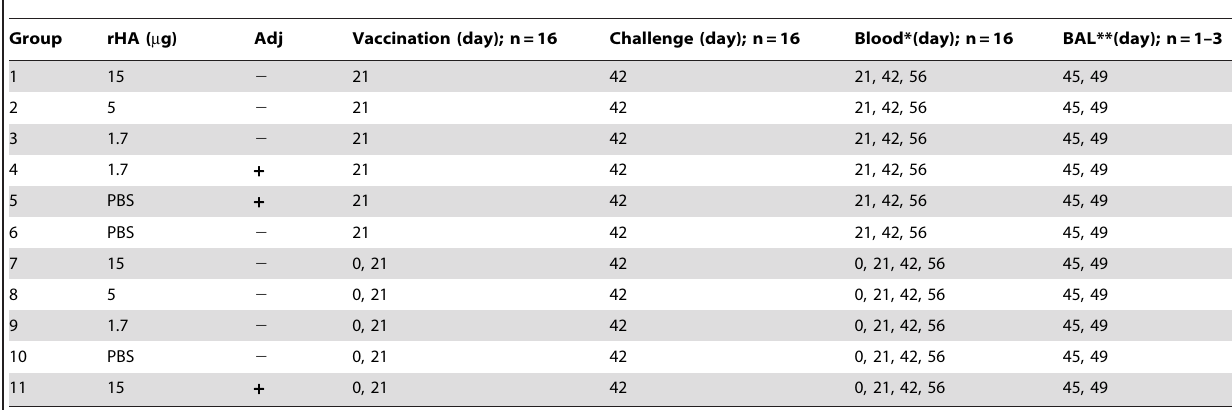
Table 2. Mouse challenge study